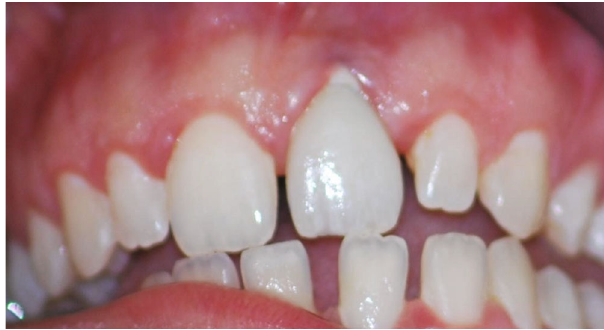
Figure 3: A temporary therapeutic element was inserted.